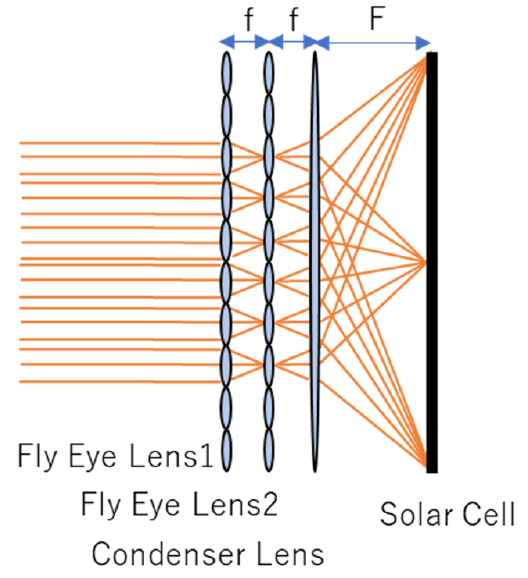
Figure 1. Solar Cell Array with Fly Eye Lens.